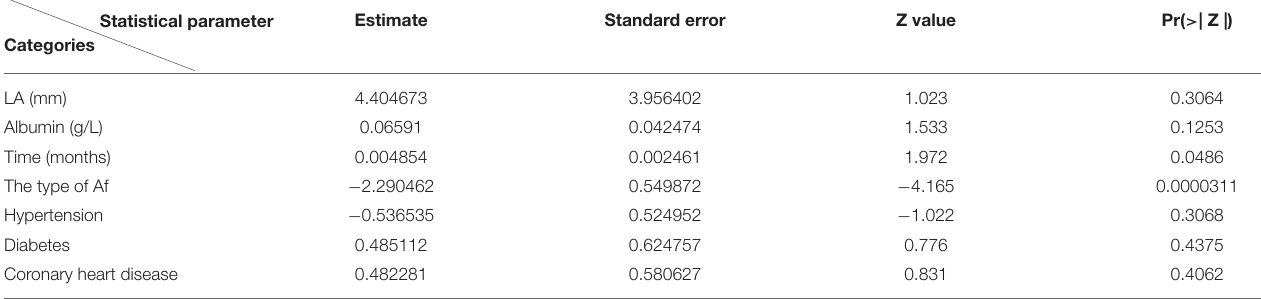
TABLE 3 | Modeling results using logistic regression.